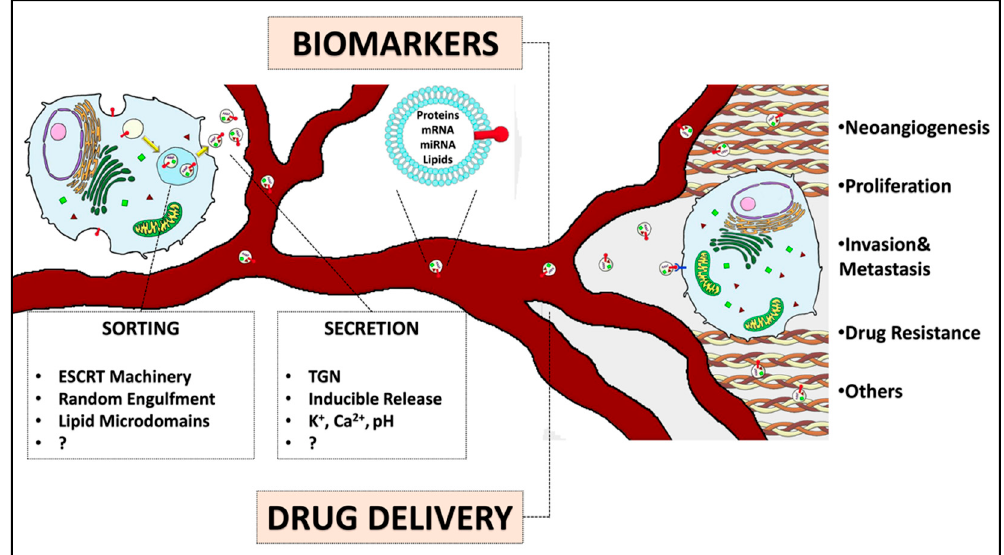
Figure 1. EEVs’ biogenesis, content, and functions. EEVs are eventually secreted by any cells in the bloodstream to deliver their cargos to targeted cells, regulating, among other functions, neoangiogenesis, proliferation, invasion, metastasis, and drug resistance. EEVs are demonstrated to be useful biomarkers for cancer diagnosis and prognosis. These nanovesicles could also be engineered in order to be loaded with drugs or therapeutic molecules.